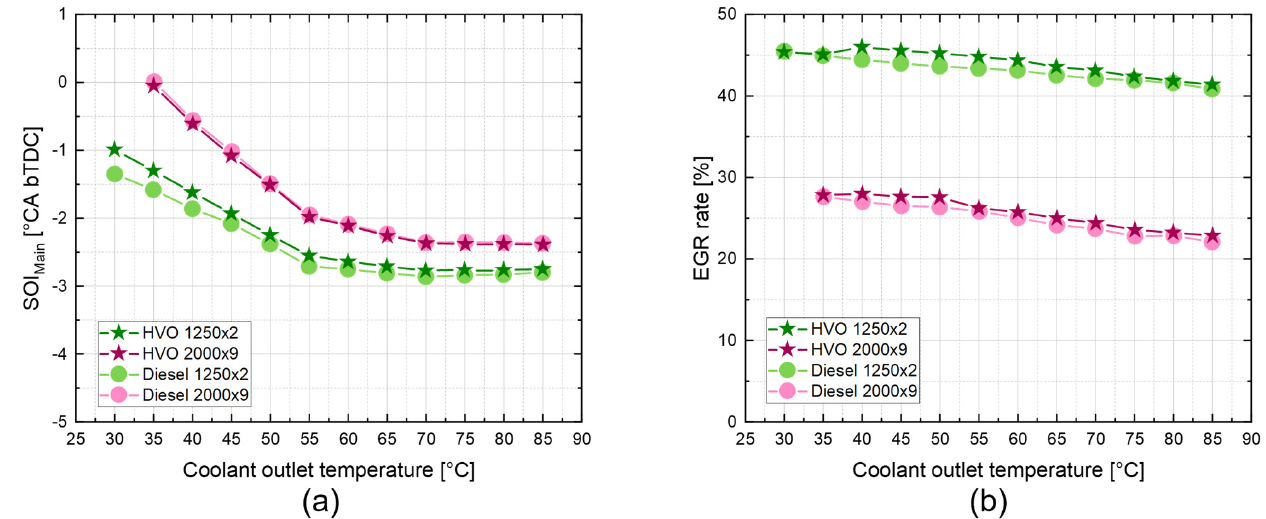
Figure 4. SOI Main ( a ) and EGR rate ( b ) measured at various coolant temperatures along the “natural” warm-up ramps of the engine. Comparison between diesel and HVO at 1250 × 2 and 2000 × 9. Light and dark greens represent 1250 × 2, pink and purple represent 2000 × 9. Circles represent diesel, while stars represent HVO.